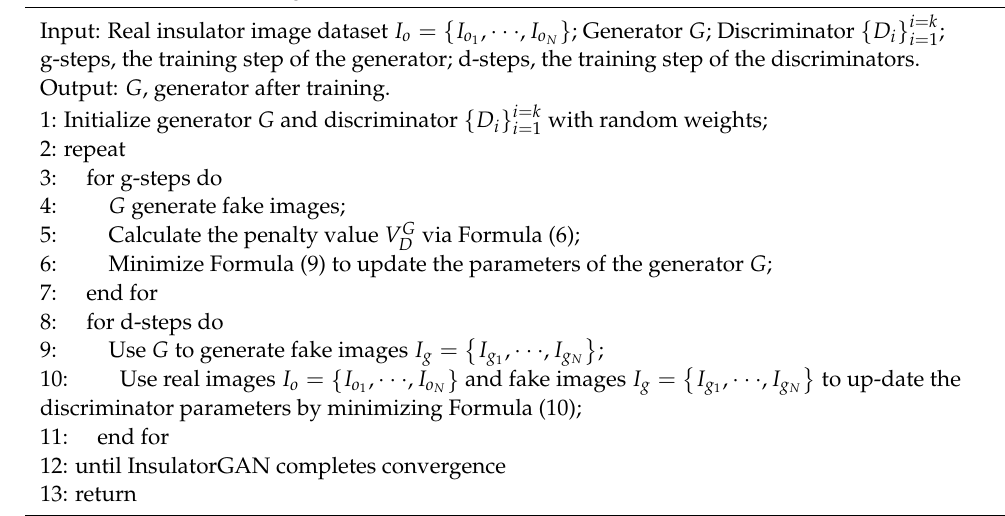
Algorithm 1. The Training Process of